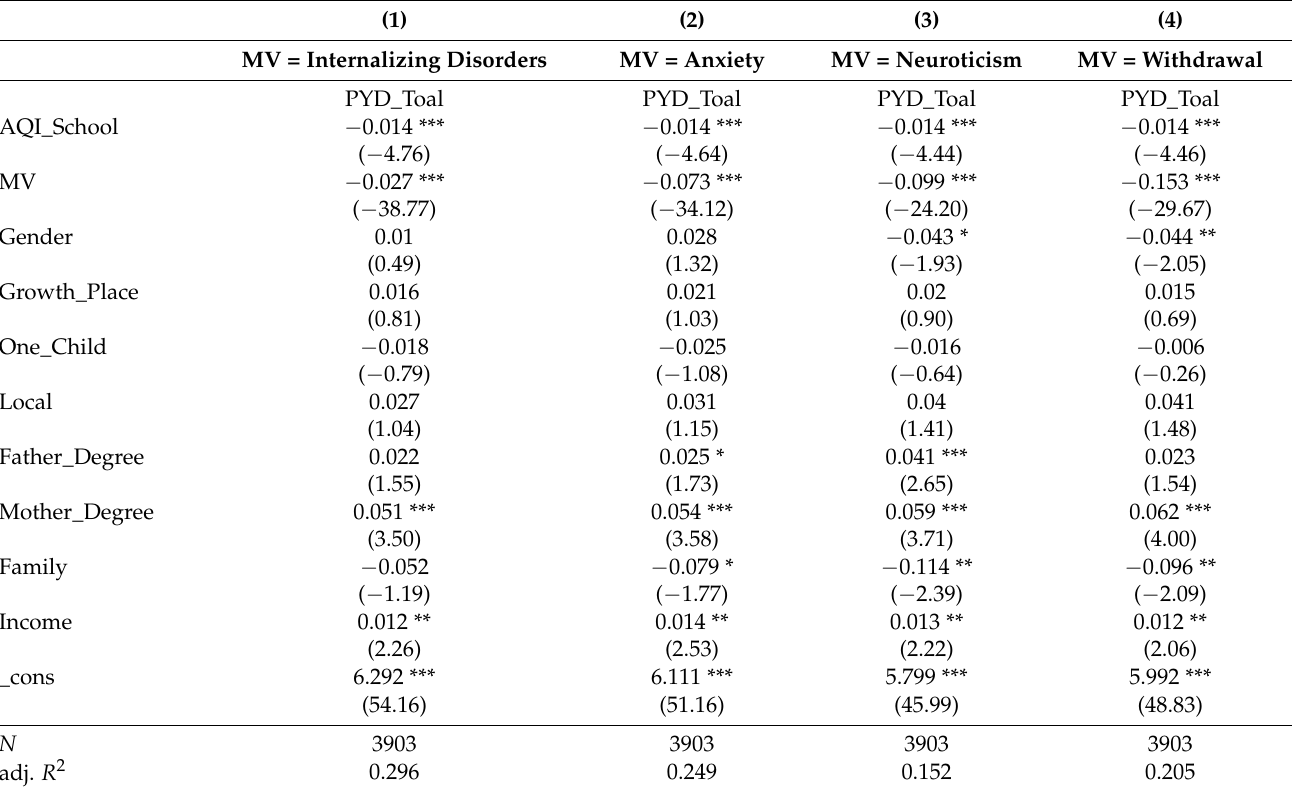
Table 6. The test of mediating mechanisms: Step